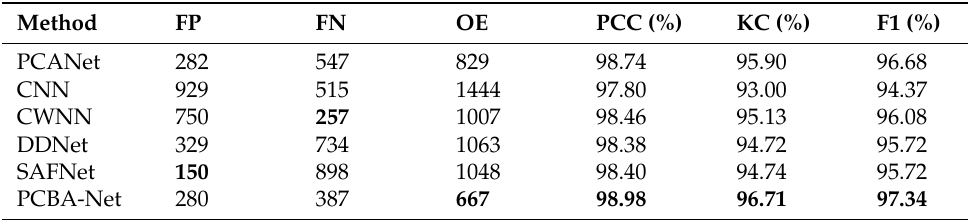
Figure 13. Visualization of comparative experiments for the Sulzberger dataset. ( a ) Ground-truth image. ( b ) Result of PCANet. ( c ) Result of CNN. ( d ) Result of CWNN. ( e ) Result of DDNet. ( f ) Result of SAFNet. ( g ) Result of the presented PCBA-Net. Table 4. Change detection results for Sulzberger dataset.